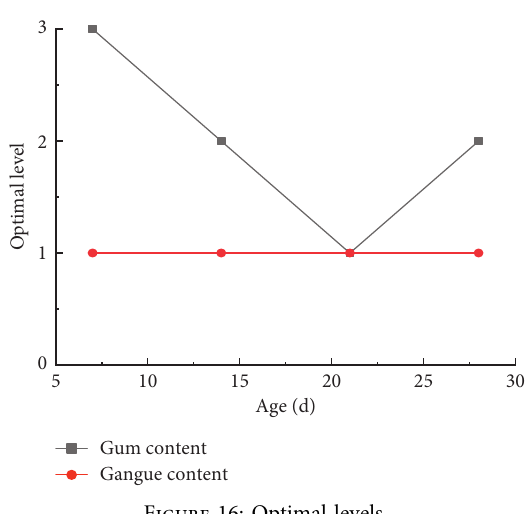
Figure 16: Optimal